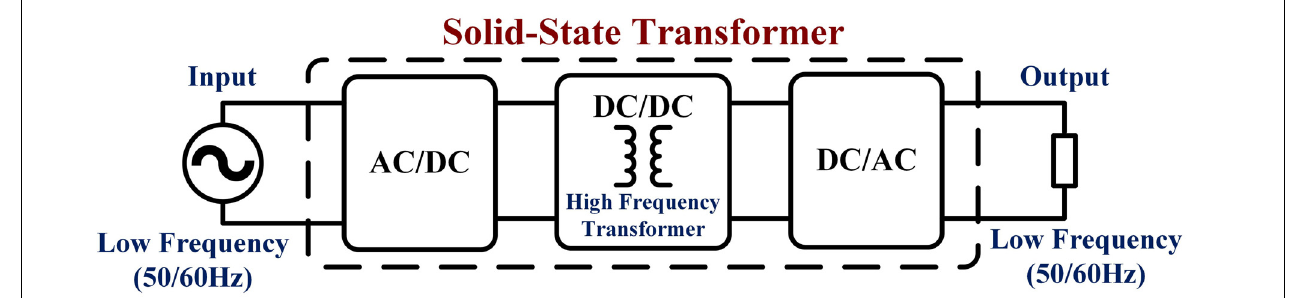
FIGURE 5 | Topology of solid-state